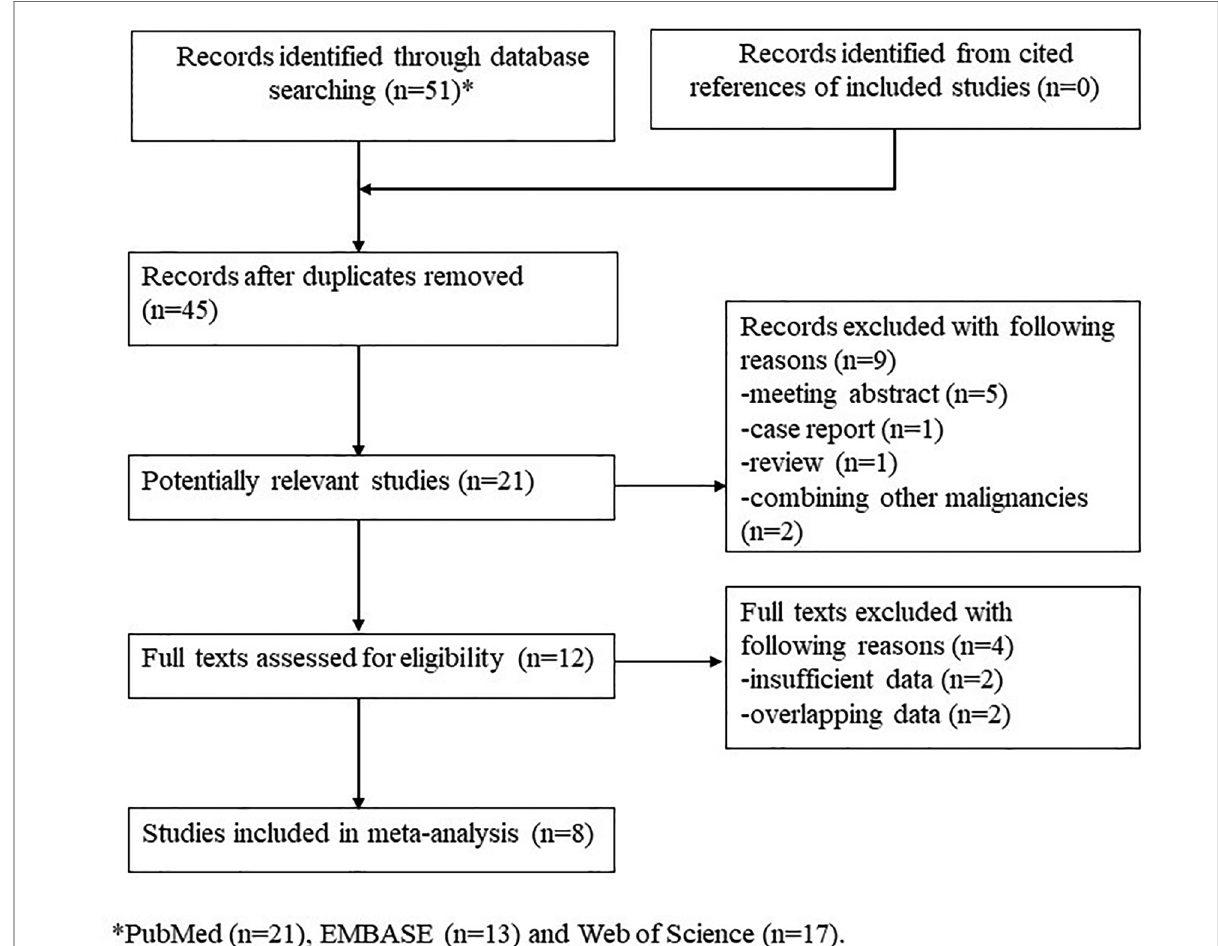
FIGURE 1 The fl ow diagram of this